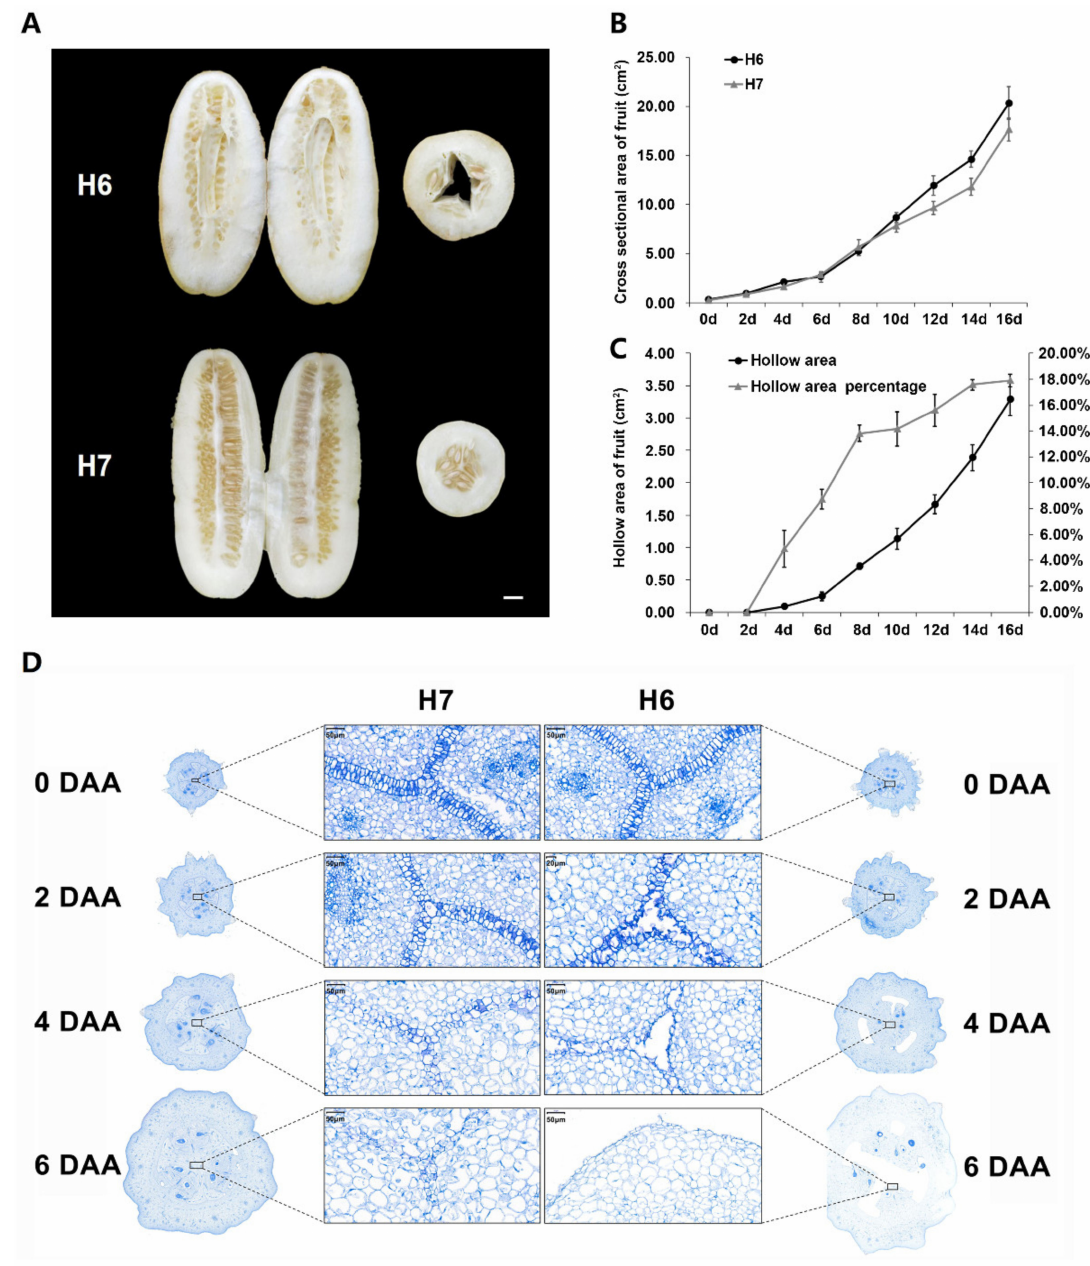
Figure 1. Identification of cucumber H6 and H7 hollow traits: ( A ) Internal phenotypic characteristics and hollow traits of H6 and H7 cucumber fruits, the fruits are at the maturity stage (Bars, 1 cm); ( B ) changes in the cross-sectional area between H6 and H7 from 0 to 16 days of fruit development; ( C ) changes of hollow area and percentage of hollow area in H6 from 0 to 16 days of fruit development; ( D ) cell structure of cross sections of H6 and H7 fruits between 0 and 6 days. DAA, day after